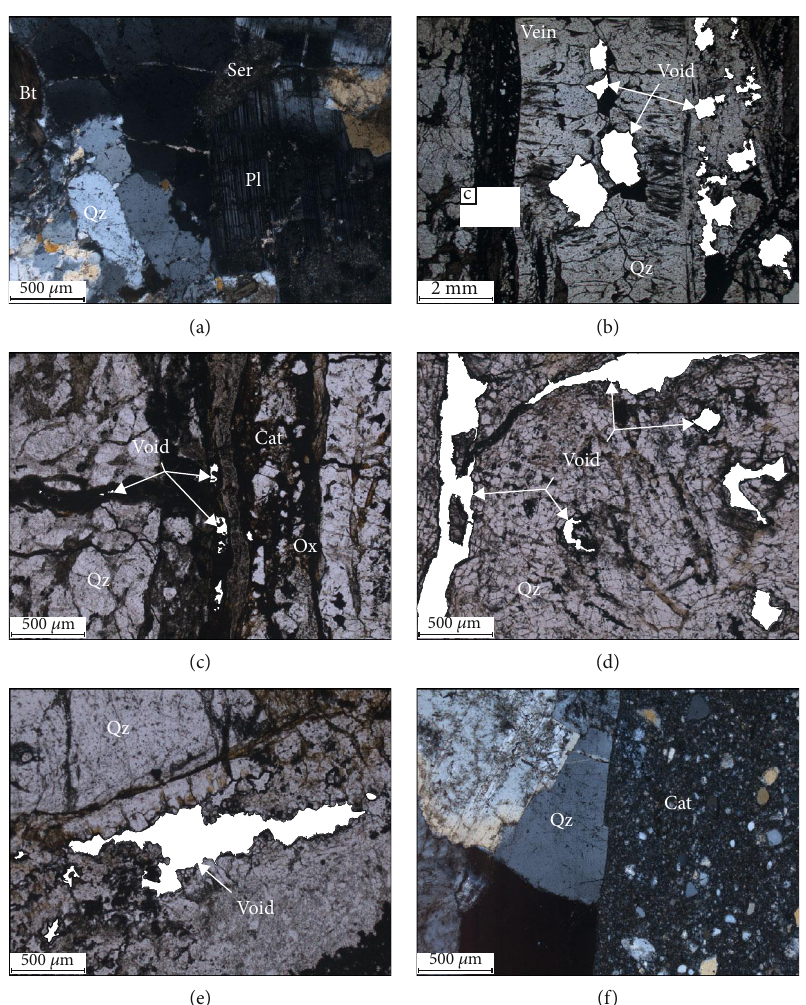
Figure 7: Facies, textures, and composition details of the Pontgibaud hydrothermal system. (a) LPA thin-section view of least altered and unfractured samples. Others (b – e) show altered and fractured facies which are much more present in the samples. (c) is a zoom of a part of (b) and shows voids present at smaller scales. (f) Crosspolar thin-section view of cataclasite. Abbreviations from Whitney and Evans, [100]: Pl: plagioclase; Bt: biotite; Qz: quartz; Ser: sericite. Other abbreviations: Cat: cataclasite; Ox: oxyde. The thin section come from samples retrieved from the Peyrouses 1 borehole, located within the Pontgibaud CFZ (see location in Figure